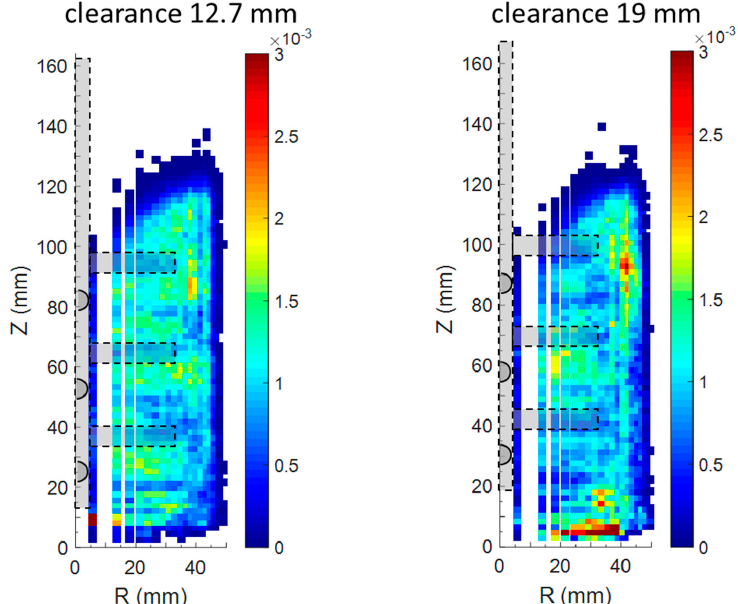
Figure 9. PEPT normalised tracer occupancy plot for two values of clearance: 12.7 mm and 19 mm. Test case using the bead loading of 2.4 kg and the impeller speed of 300 rpm.